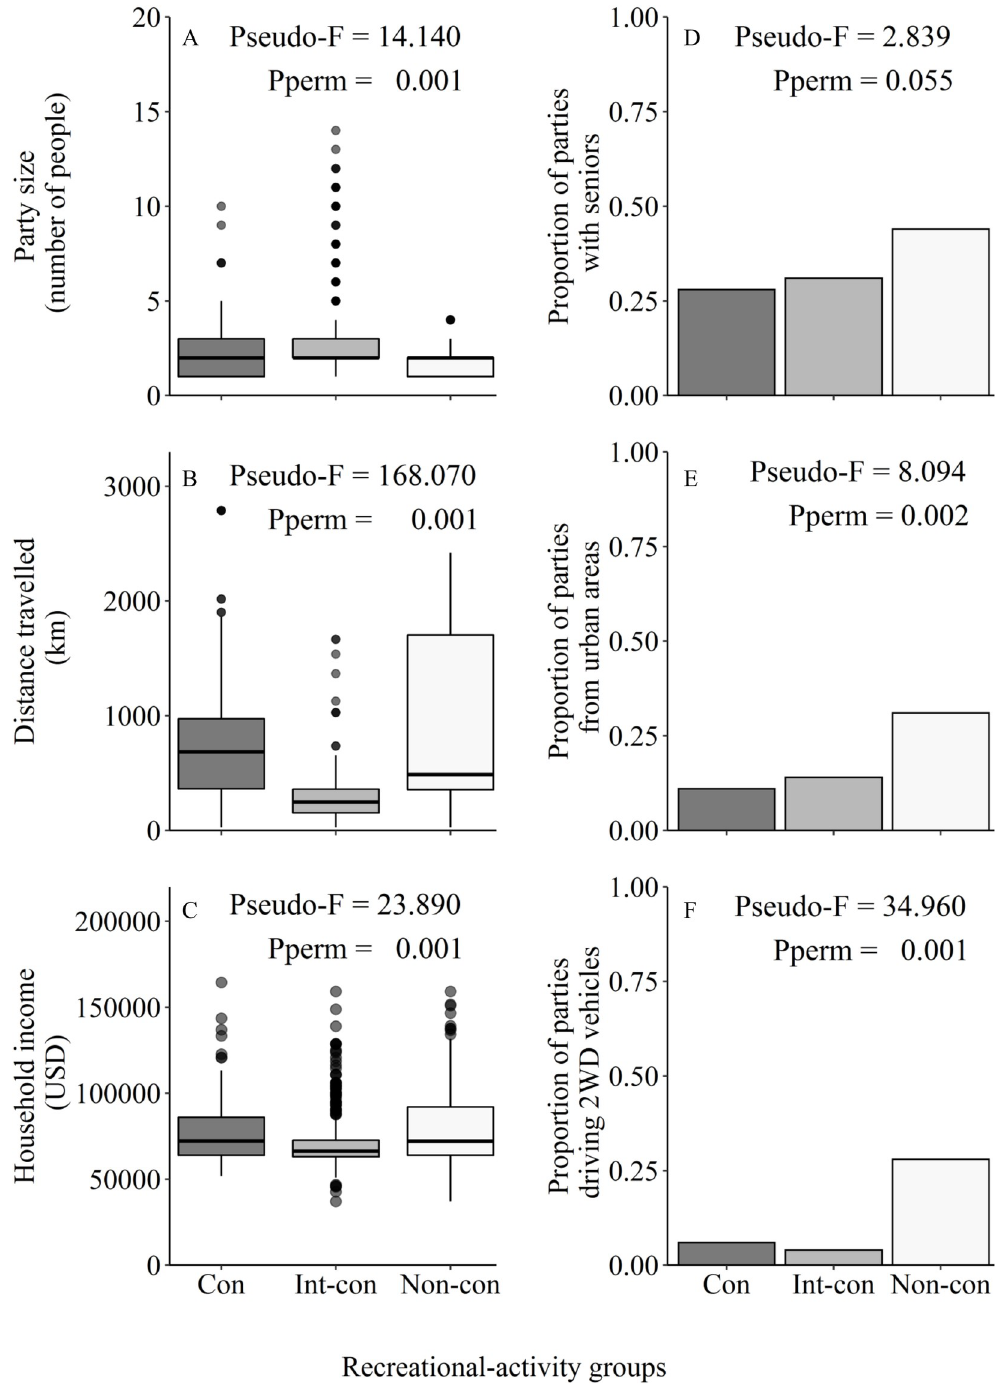
Fig 2. Box plots and bar graphs of the sociodemographic attributes of the consumptive (Con [hunting]; dark gray), intermediate-consumptive (Int-con [fishing]; medium gray), and non-consumptive (Non-con [e.g., wildlife watching]; light gray) recreational-activity groups surveyed at Valentine National Wildlife Refuge during 2017–2018. Box plots (A-C) illustrate attribute variability for party size, distance travelled, and household income among surveyed groups. Horizontal lines represent the median, boxes represent the range from 25th to 75th percentile, upper whiskers extend from box to largest value at most 1.5 � IQR (interquartile range), lower whiskers extend to lowest value no further than 1.5 � IQR, and points represent outliers. Bar graphs (D-F) illustrate proportions of surveyed parties with seniors present ( � 65 years), from urban areas ( � 2590 people per square kilometer) and driving two-wheel drive (2WD) vehicles for surveyed